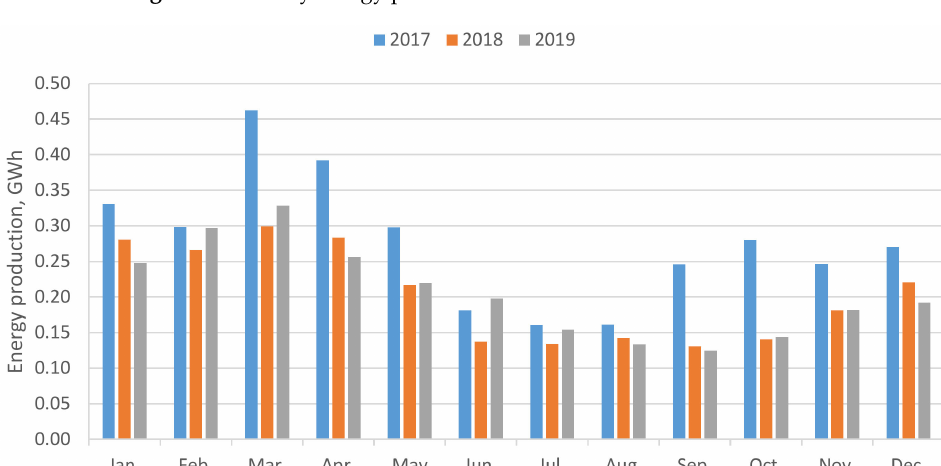
Figure 8. Monthly energy production for the hydroelectric power station in